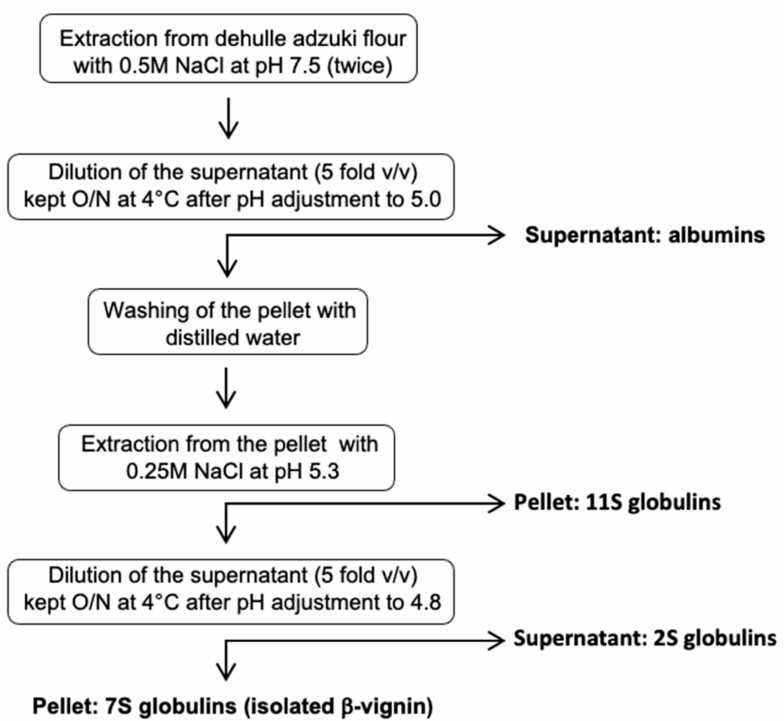
Figure 2. Schematic diagram of isolation of adzuki bean β -vignin protein by the preparative method.